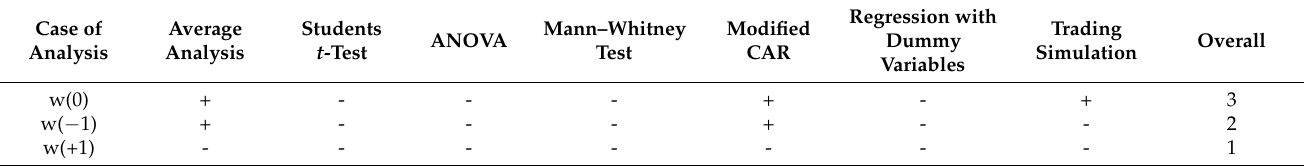
Table 3. Overall results for the expiration price effects: weekly data.